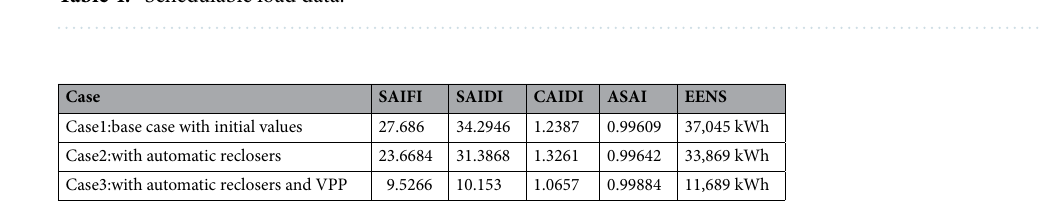
Table 5. Reliability results of Industrial feeder.